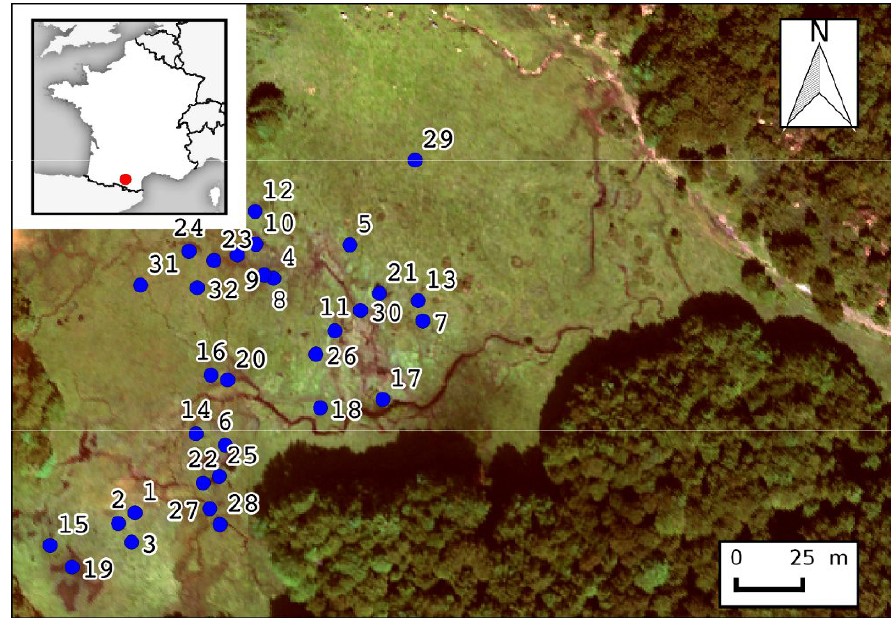
Figure 1. Location of the in situ spectroradiometer measurements—True color composite made from hyperspectral (HySpex) aerial imageries acquired on the 09/12/2014 (R = 639.98nm, G = 549.06nm, B =